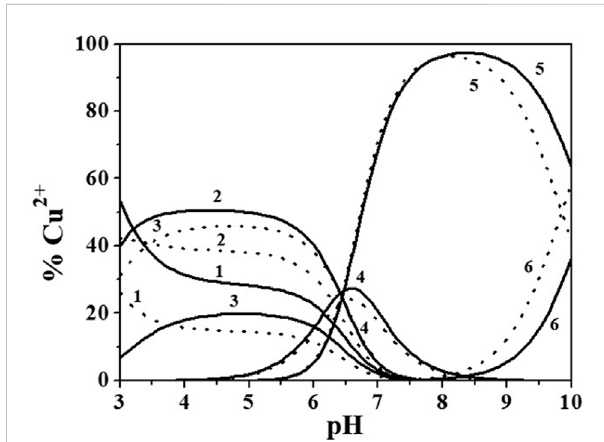
FIGURE 5 Distribution diagram of Cu 2+ / Alg 2- species at I = 0.149 (solid line) and 0.984 (dotted line) mol dm − 3 , c cu2+ = 0.70 mmol dm − 3 , c Alg2- = 2.10 mmol dm − 3 . Species: 1. Free Cu 2+ ; 2. Cu( Alg ) 0 (aq) ; 3. Cu( Alg ) 2 2- ; 4. Cu( Alg )OH − ; 5. Cu( Alg )(OH)22 − ; 6. Cu( Alg )(OH) 3 3- .